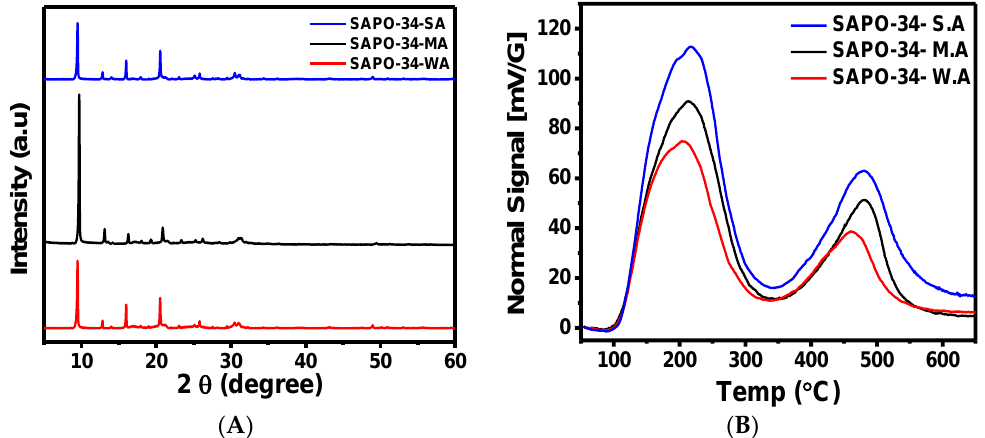
Figure 2. ( A ) XRD patterns of SAPO-34 zeolite samples. ( B ) Acidic strengths of SAPO-34 zeolites by temperature-programmed desorption of ammonia (NH 3 -TPD). SA, MA, and WA represent strongly, moderately, and weakly acidic H-SAPO-34 zeolites, respectively.